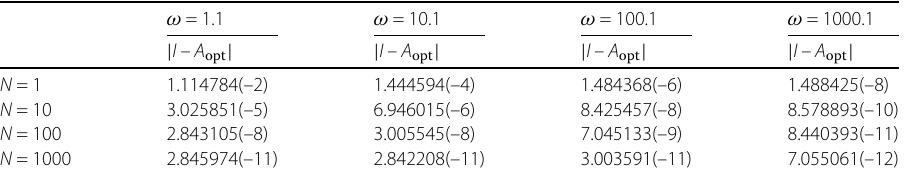
Table 2 The absolute values for the error (55) of the optimal quadrature formula (54) for N = 1,10,100,1000 and ω =